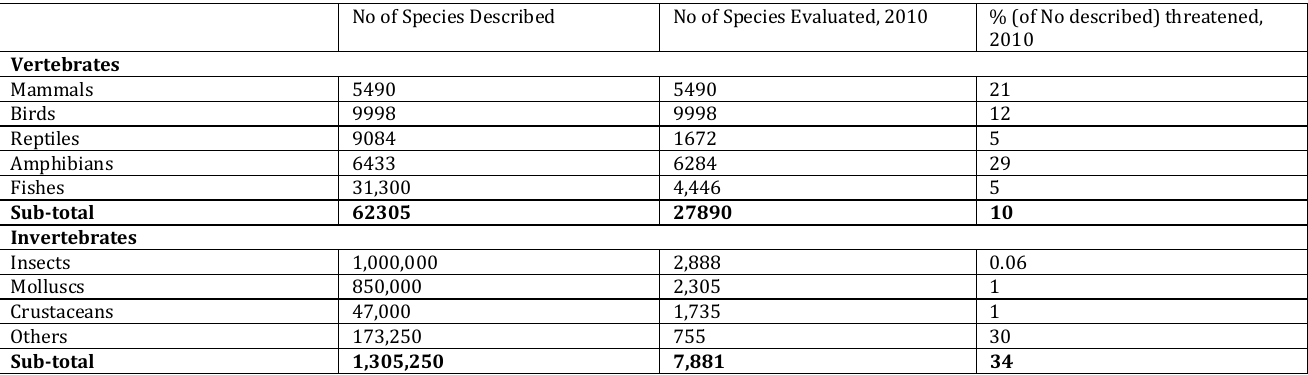
Table 3: Rate of Extinction in Recent